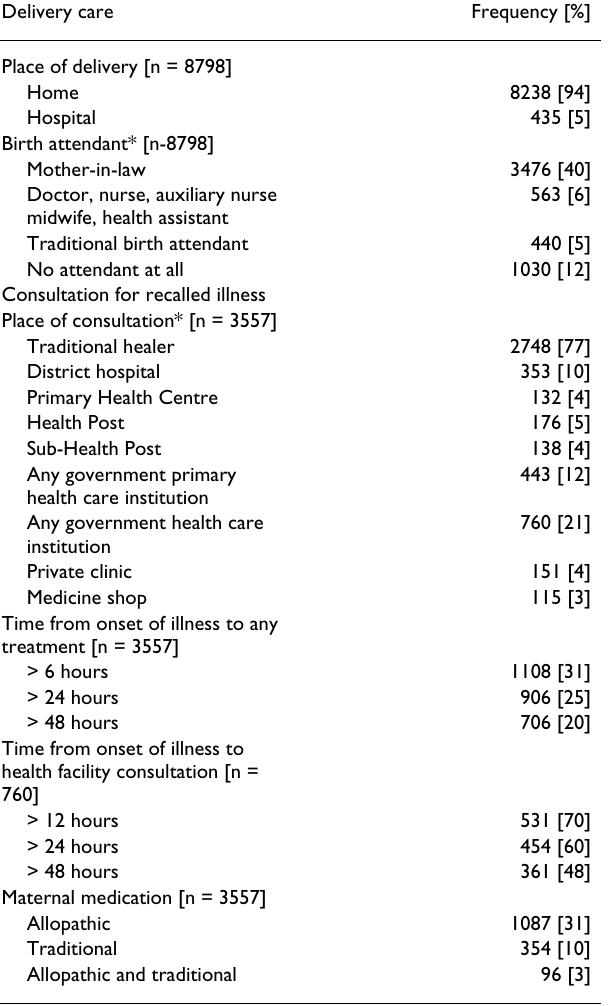
Table 2: Delivery care and consultation findings from the survey questionnaire Delivery care